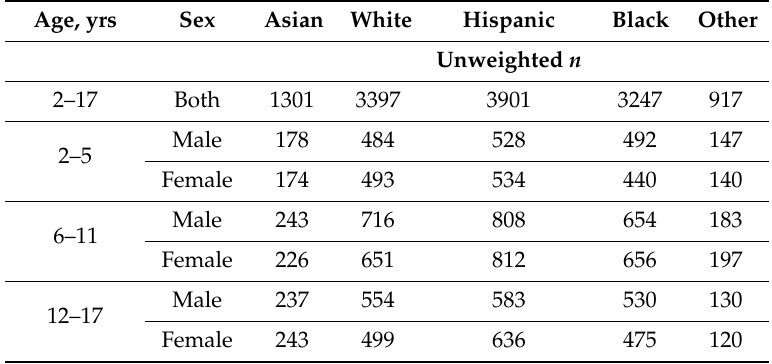
Table 1. Sample size from 2011–2018 US National Health and Nutrition Examination Survey (NHANES).